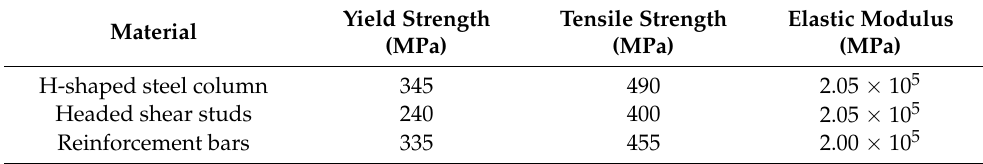
Table 1. Material properties of steel column, shear studs and reinforcement